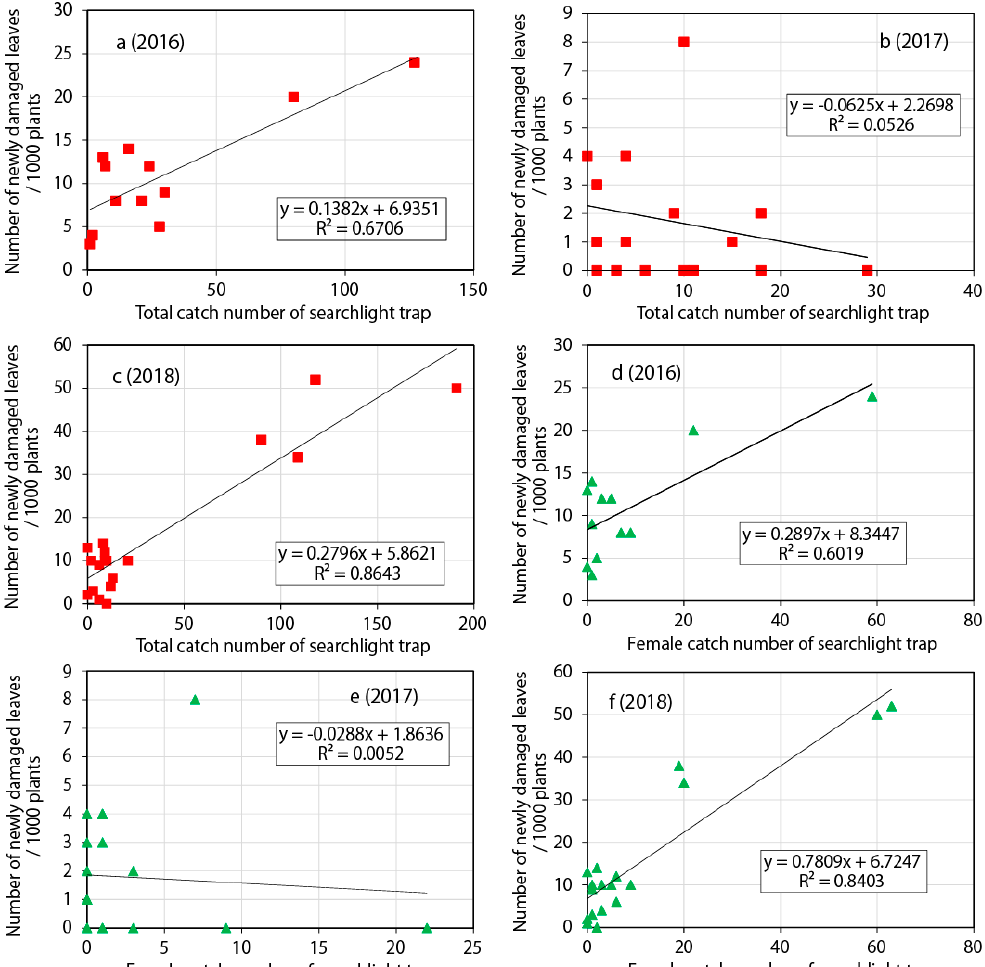
Figure 5. Linearity between the catch number of the searchlight trap and the number of newly damaged leaves in August and September 2016–2018. Total catch numbers of the searchlight trap in ( a ) 2016 (date shift ds = 5, n = 12), ( b ) 2017 ( ds = 5, n = 19), and ( c ) 2018 ( ds = 6, n = 18). Female catch number of the searchlight trap in ( d ) 2016 ( ds = 5, n = 12), ( e ) 2017 ( ds = 5, n = 19), and ( f ) 2018 ( ds = 6, n = 18).